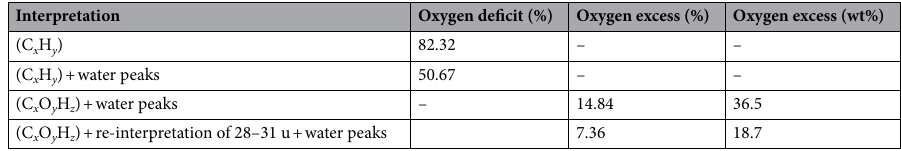
Table 1. Calculated oxygen deficit and excess by different peak